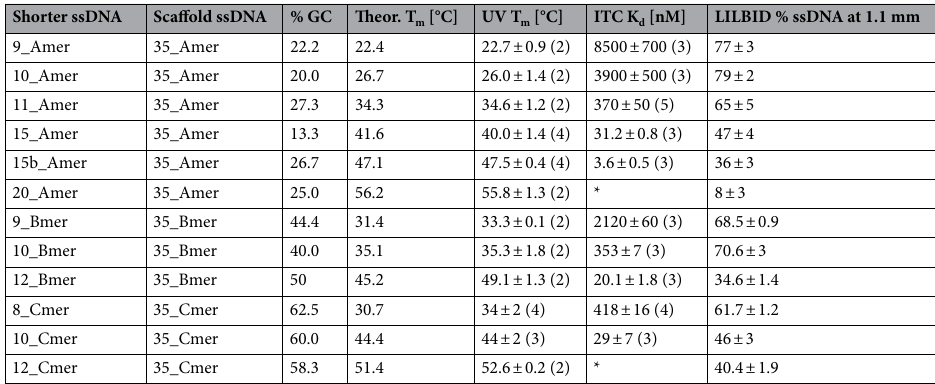
Table 2. For each DNA double strand the percent GC content, theoretical and experimental melting temperatures, dissociation constants and % ssDNA observed with LILBID at 1.1 mm droplet explosion width are shown. Percent GC is shown for only the double-stranded section of each sample. Theoretical T m s were calculated for 10 µM dsDNA, 0.5 mM MgCl 2 using https ://eu.idtdn a.com/calc/analy zer. UV T m s and ITC K d s are given as mean ± s.e.m., and the number of replicate UV or ITC curves is given in parentheses. Percent ssDNA at 1.1 mm represent the mean from five LILBID dissociation curves ± s.e.m. *Analysis was not